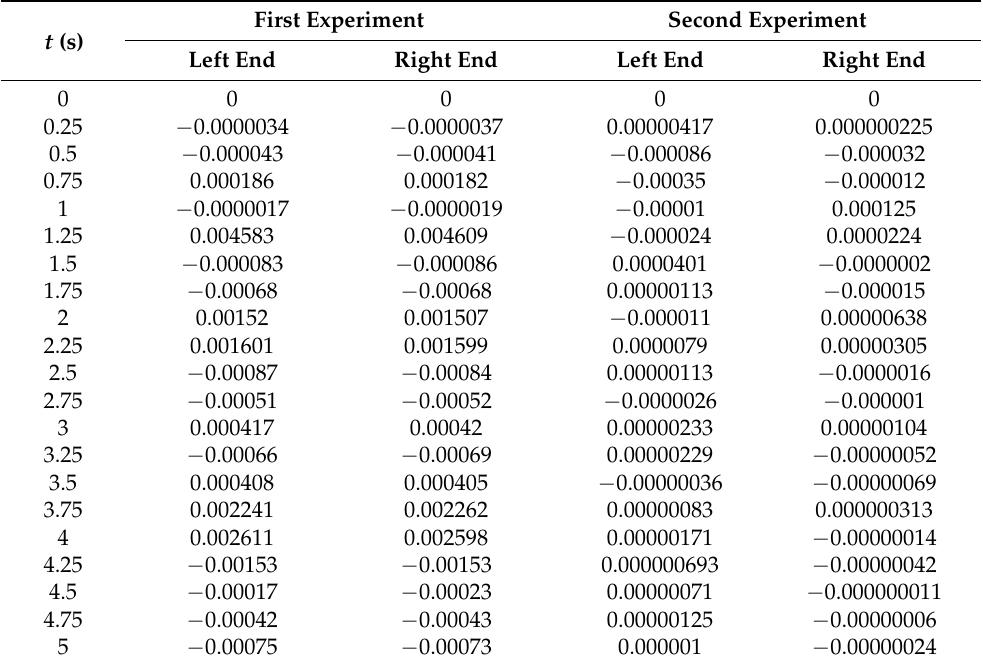
Table 3. Relative errors ε for the first and second experiments at given angular velocities of both the shaft ends in the time interval Δ t = 0.25 s.